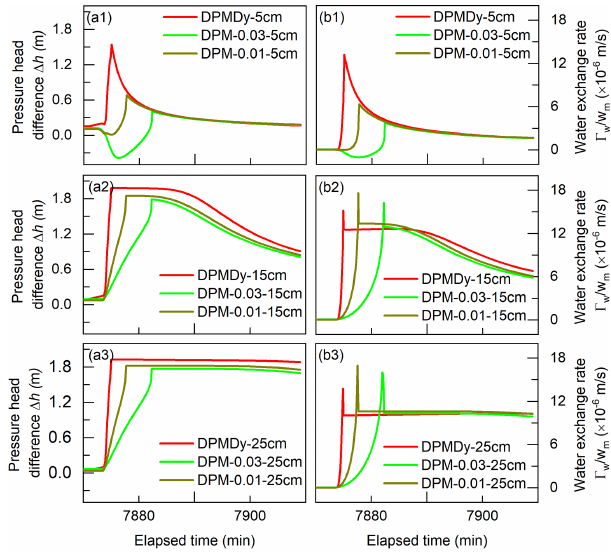
Figure 18. Pressure head difference (a1–a3) and water exchange rate (b1–b3) between the two domains at the 5, 15 and 25cm depths during the sixth rainfall event. The positive value of water exchange rate is for the water flowing from the crack to the matrix domain, while the negative value is for the opposite